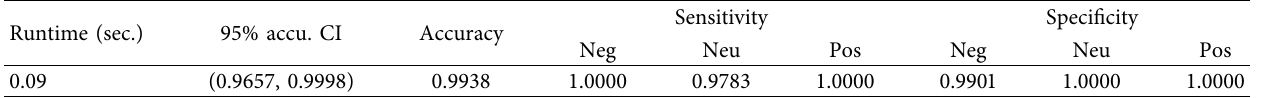
Table 7: Performance statistics of the random forest model.